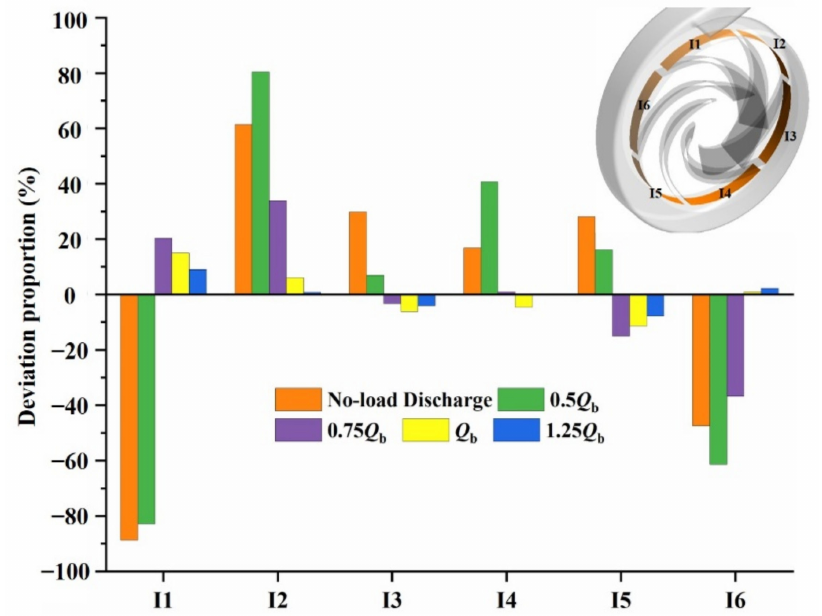
Figure 10. Flow deviation ratio in the different impeller